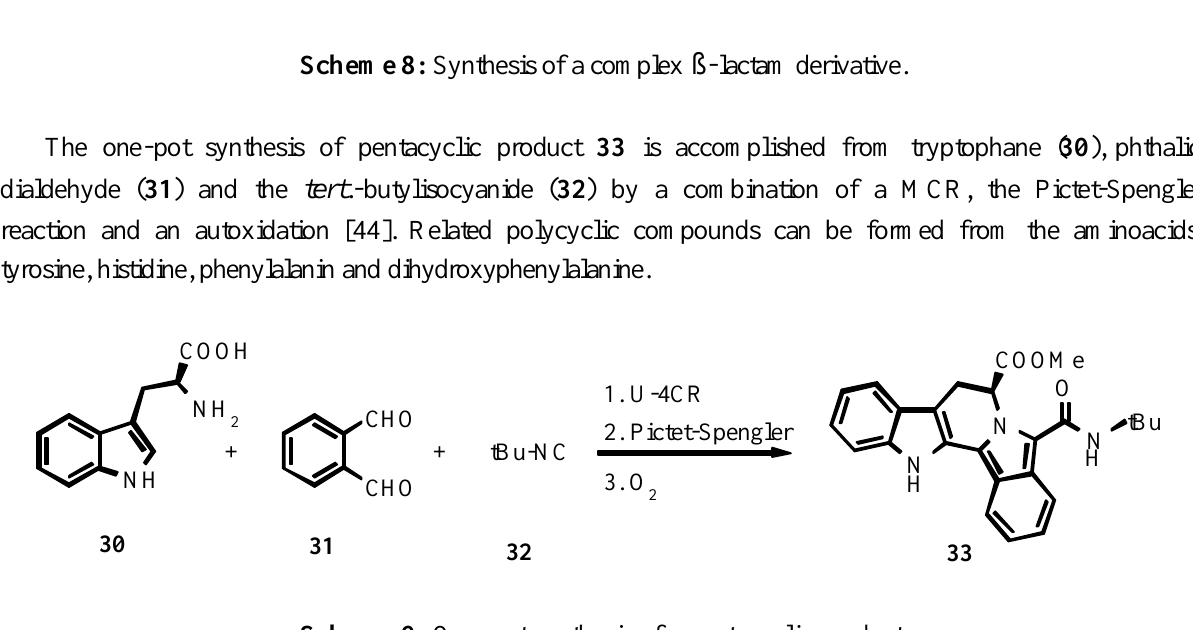
Scheme 9: One-pot synthesis of a pentacyclic